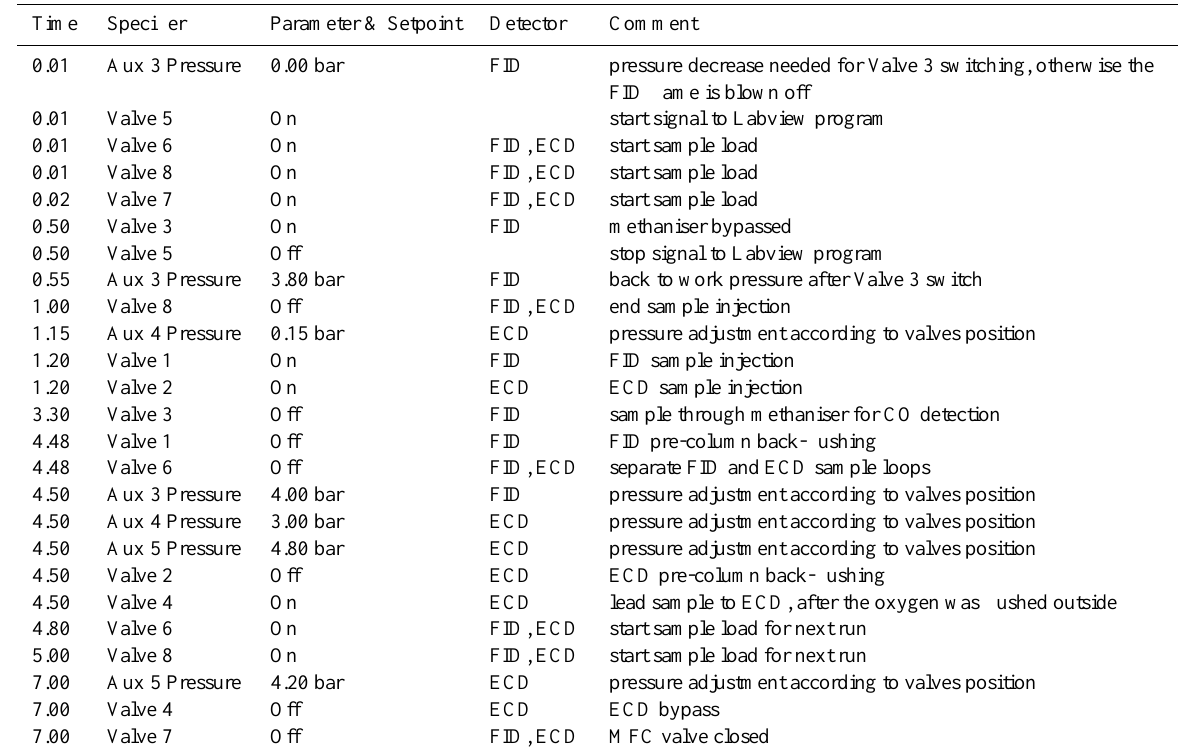
Table A2. Time table.